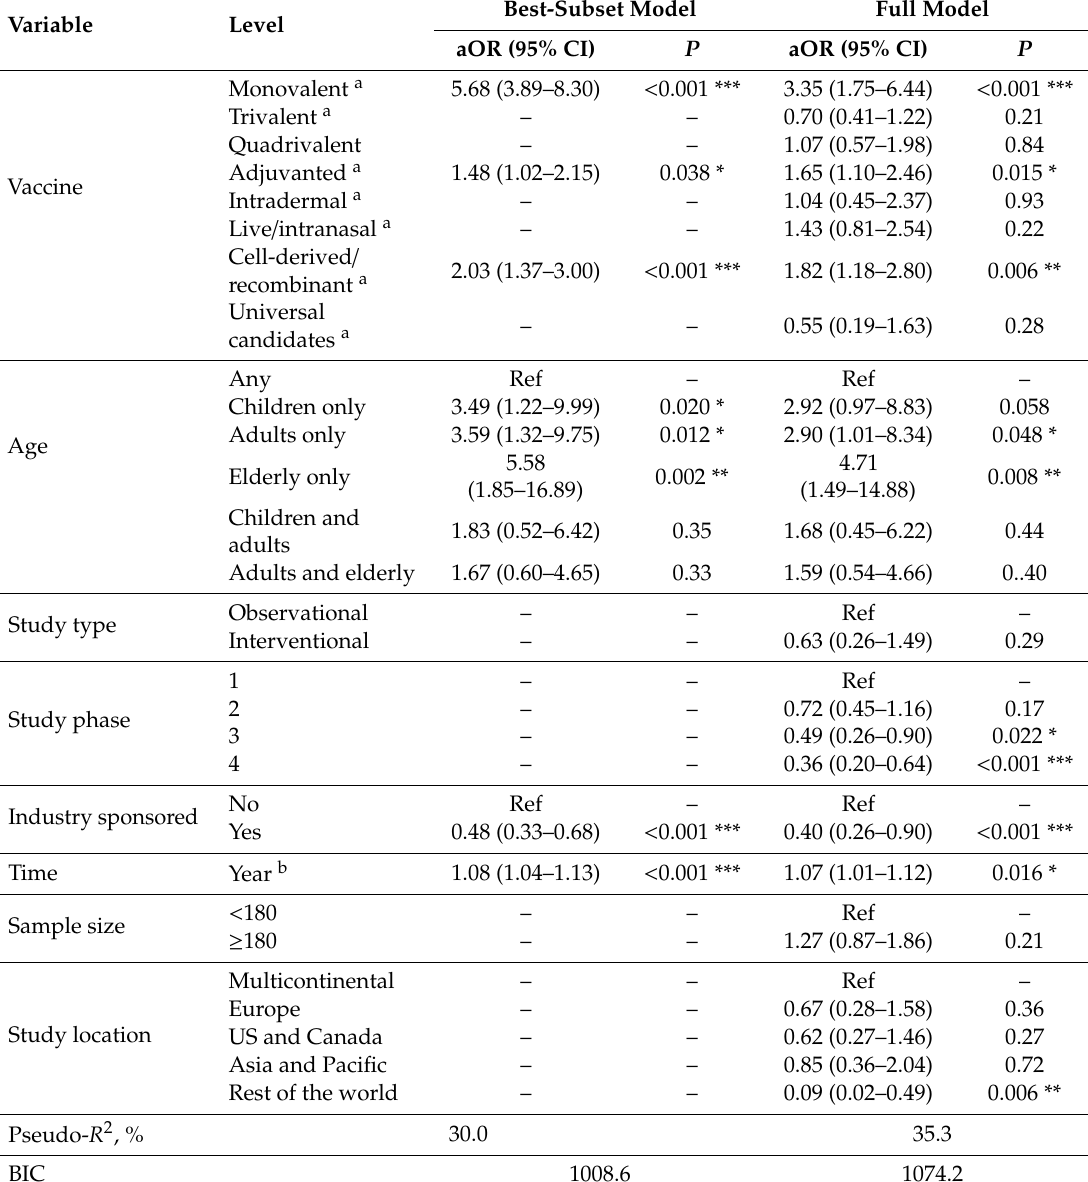
Table 2. Multivariable logistic regression models to predict the use of immunological assays measuring neutralizing